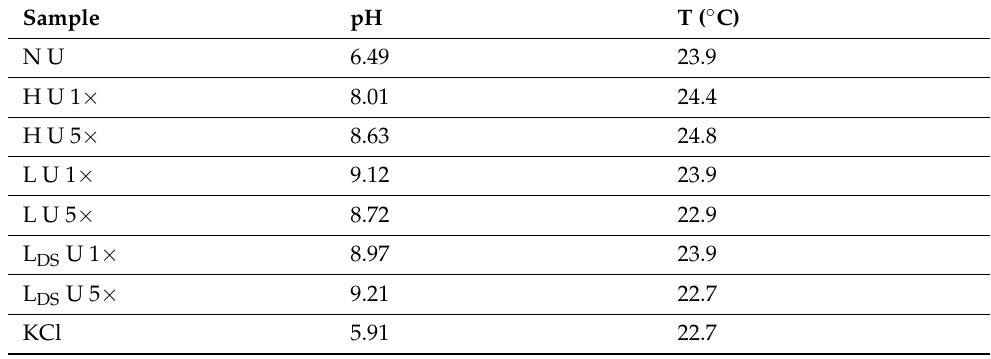
Table 9. pH of the aqueous extract of medical mask samples cut into strips before and after